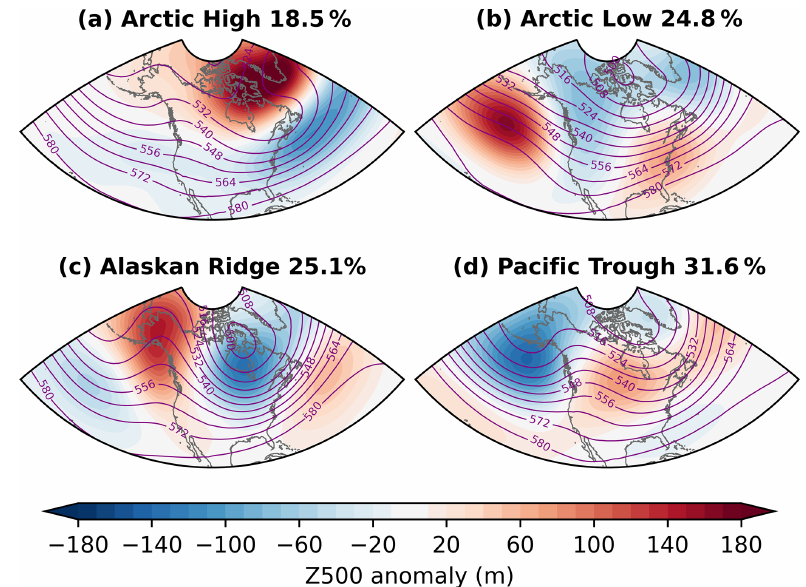
Figure A1. Composite-mean 500hPa geopotential height (Z500) (purple contours, dam) and anomalies (shading, m) for all days assigned to each of the four North American wintertime weather regimes during DJFM 1979–2021. The proportion of days assigned to each regime are shown as percentages.